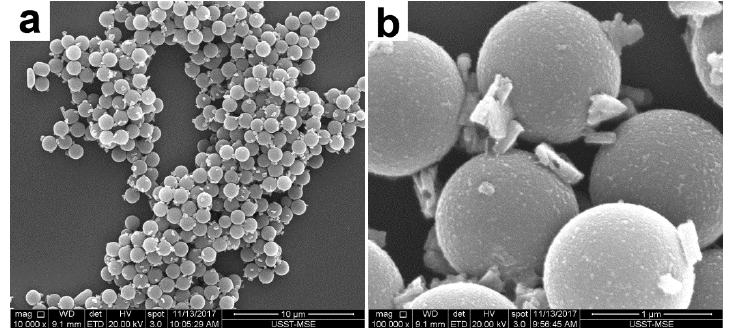
Figure 9. SEM images of the products prepared at 50 ◦ C (run 8) at ( a ) lower (10,000 × ) and ( b ) higher (100,000 × ) magnifications.